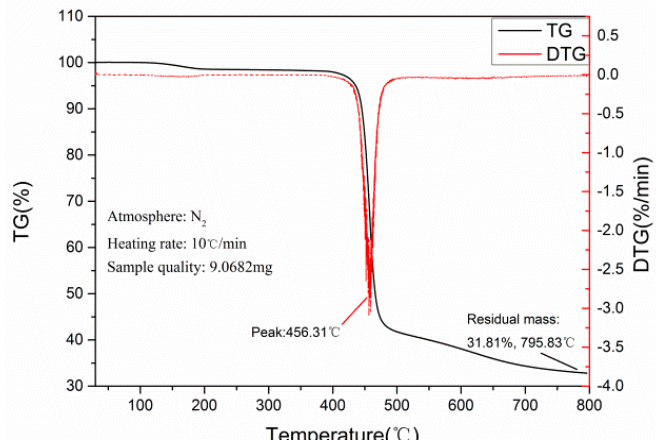
Figure 12. Thermogravimetry (TG) and differential TG (DTG) analysis curves of 1 wt.% CB/4 wt.% SiO 2 /PVDF composite.